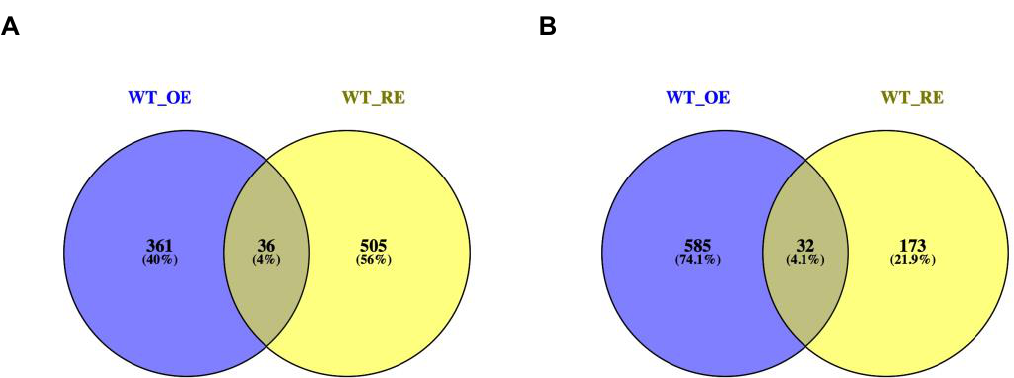
Figure 7. A Venn diagram of the number of differentially expressed genes. ( A ) Upregulated DEGs between OE and RE. ( B ) Downregulated DEGs between OE and RE.